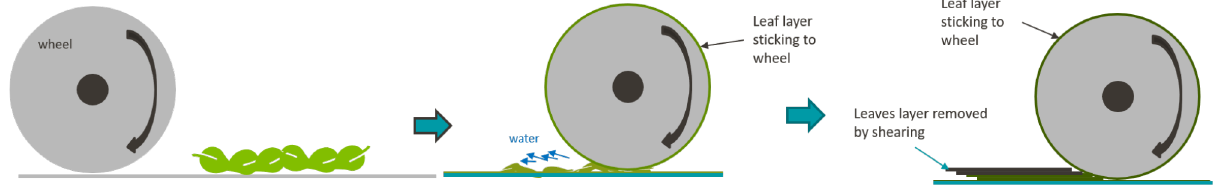
Fig. 23. Mechanism of low adhesion observed through tests using the Triboring